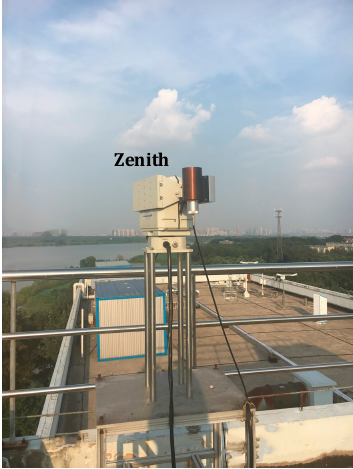
Figure 9. The Air-IRSS observation in zenith geometry on the roof of a six-story building.